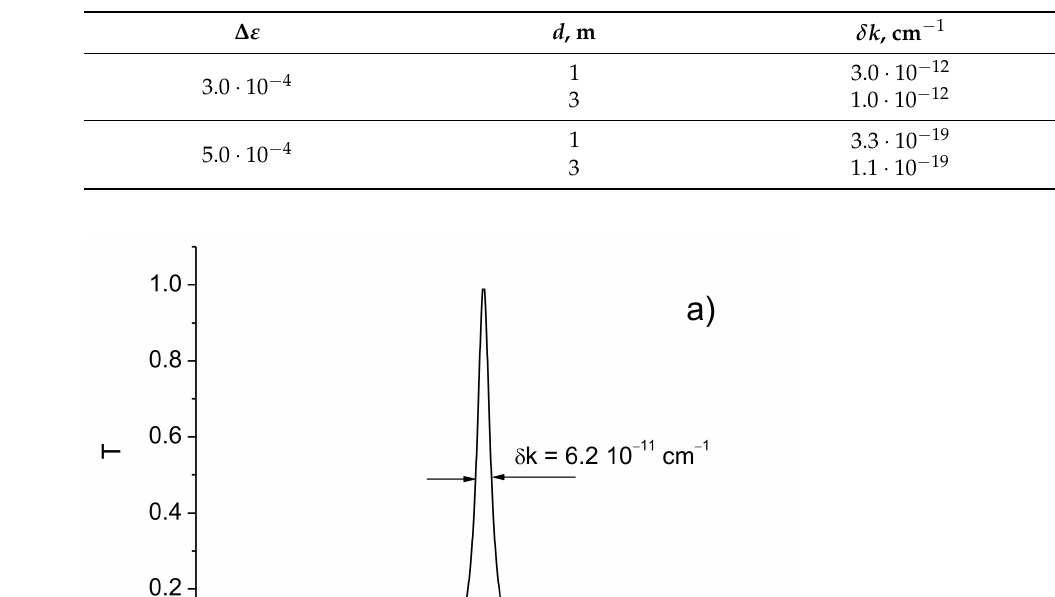
Table 4. The widths of transmission curves δ k for different modulation amplitudes ∆ ε and distances d. L = 0.40 cm, λ = 630 nm.